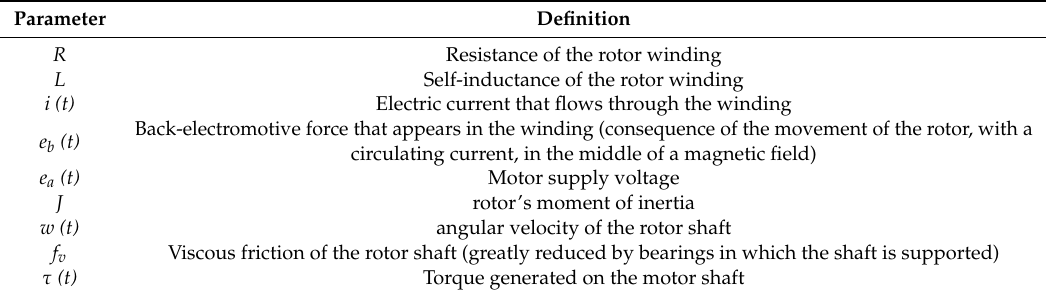
Table 1. Model parameter definition.